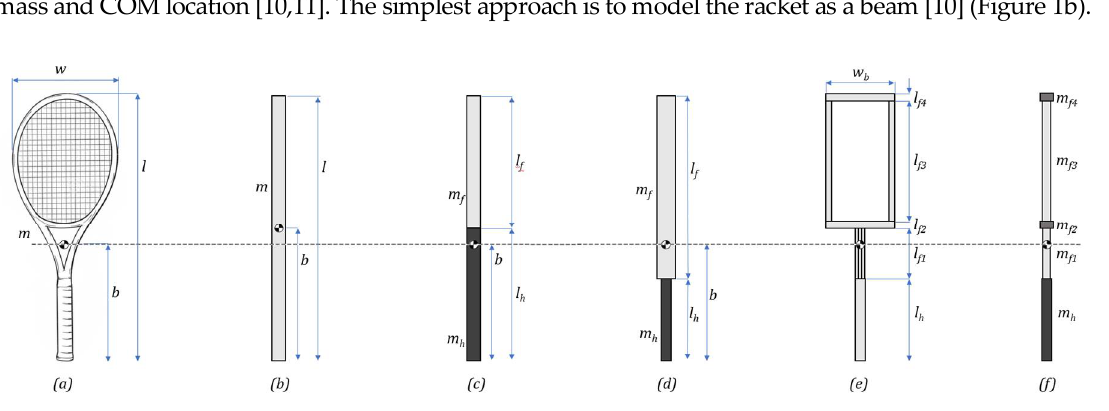
Figure 1. Schematic showing ( a ) racket; ( b ) beam; ( c ) two-section beam [10]; ( d ) unequal two-section beam [11]; ( e ) five section beam [11]—two-dimensional and ( f ) five section beam [11]—one-dimensional. m = mass, l = length, w = width, b = distance to COM, h = handle and f =